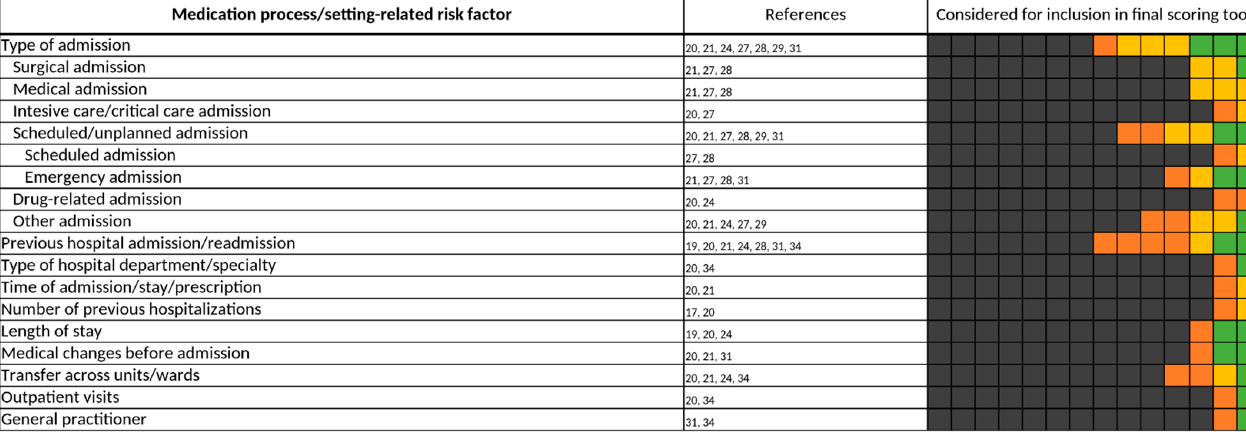
Figure 12. Medication process/setting-related risk factors. Each of the 14 boxes represents one of the included studies. The color of the boxes portrays whether a risk factor was not investigated in a study (gray), was investigated (orange), was significant in a first statistical analysis or based on expert consensus and therefore tested for inclusion in a final scoring tool (yellow), or whether a risk factor was included in a final scoring tool (green). The “citations”-column lists each study that at least investigated the respective risk factor.